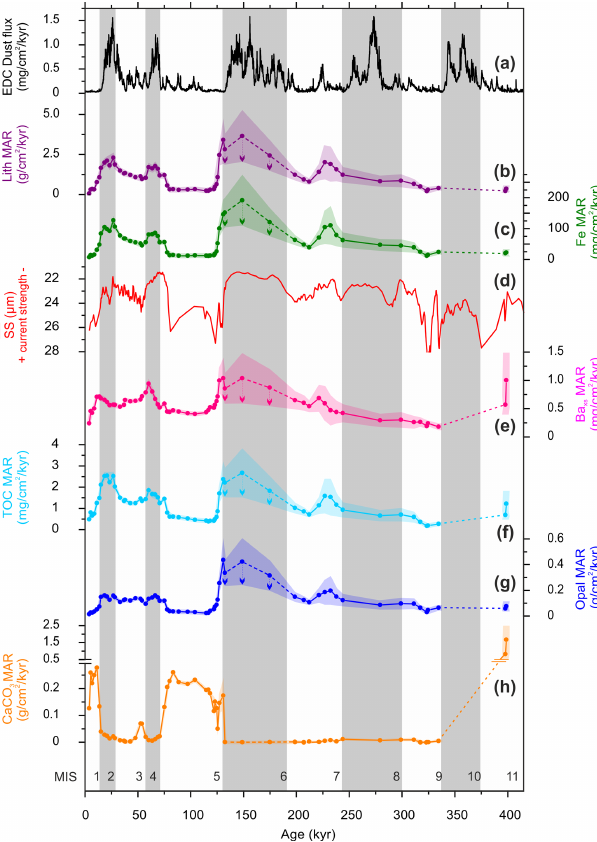
Figure 3. Southeastern Pacific (PS97/093-2) 230 Th xs -normalized mass accumulation rates (MARs) compared to dust flux in the EDC ice core (Lambert et al., 2008) and bottom current strengths of core PS97/093-2 (Toyos et al., 2020). (a) EDC dust flux; (b) 232 Th- based lithogenic MAR; (c) Fe MAR; (d) changes in bottom current strength as indicated by the sortable silt record of core PS97/093-2 (note that the Y axis is reversed); (e) Ba xs MAR; (f) TOC MAR; (g) biogenic opal MAR; and (h) CaCO 3 MAR. Shaded areas indi- cate associated errors. Numbers in the lower part of the figure in- dicate Marine Isotope Stage (MIS). Grey bars denote glacial stages according to Lisiecki and Raymo (2005). Dashed lines during MIS 6 denote the interval of extreme winnowing where MAR might be overestimated, and for MIS 10 they indicate uncertainty due to the lack of data